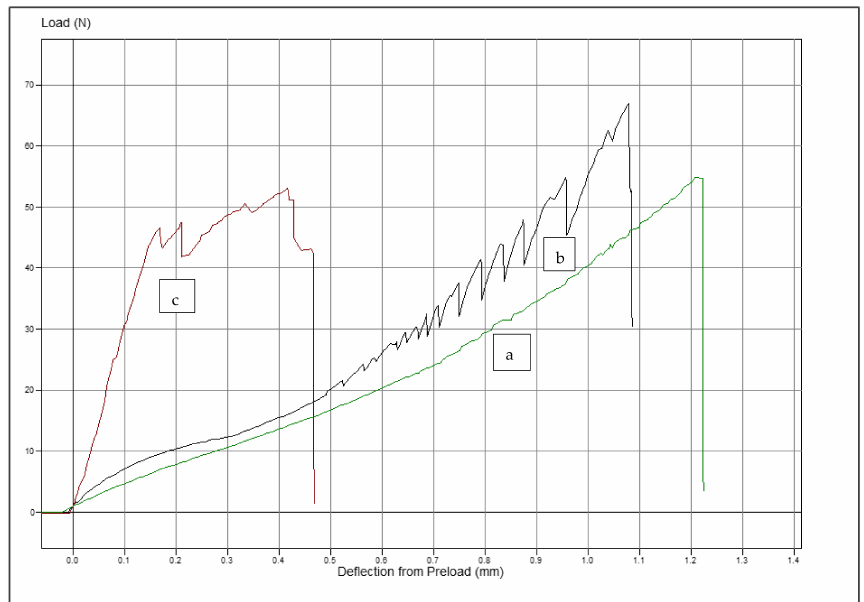
Figure 8. Examples of the load–tooth movement curves: ( a ) metal retainer (Penta One), ( b ) metal retainer (Straight 8), and ( c ) FRC retainer. All retainers were bonded 1–2 mm from the incisal edge of the teeth, and the force was applied from the axial direction. Preload from deflection was 0.05 N.